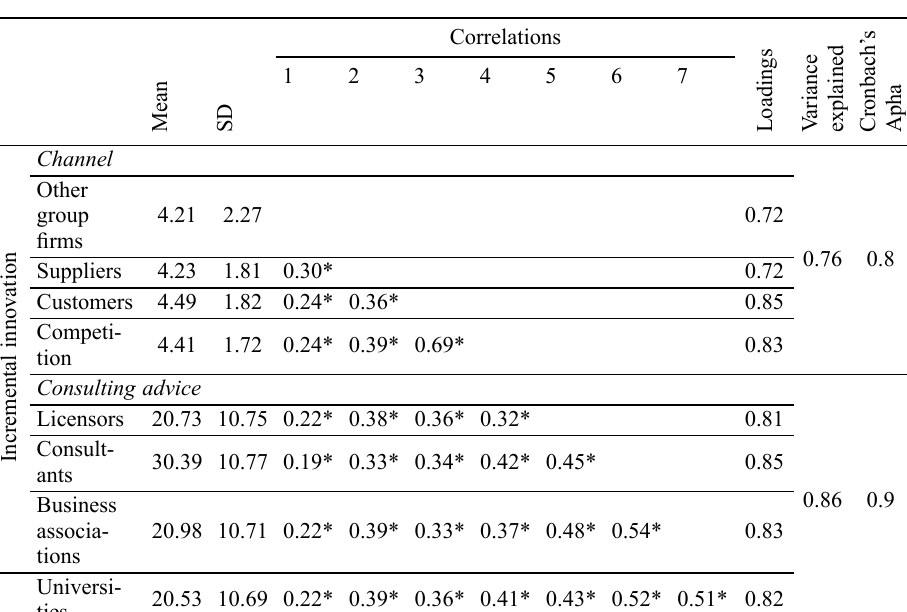
Table 6. Measurement scale: collaboration for incremental